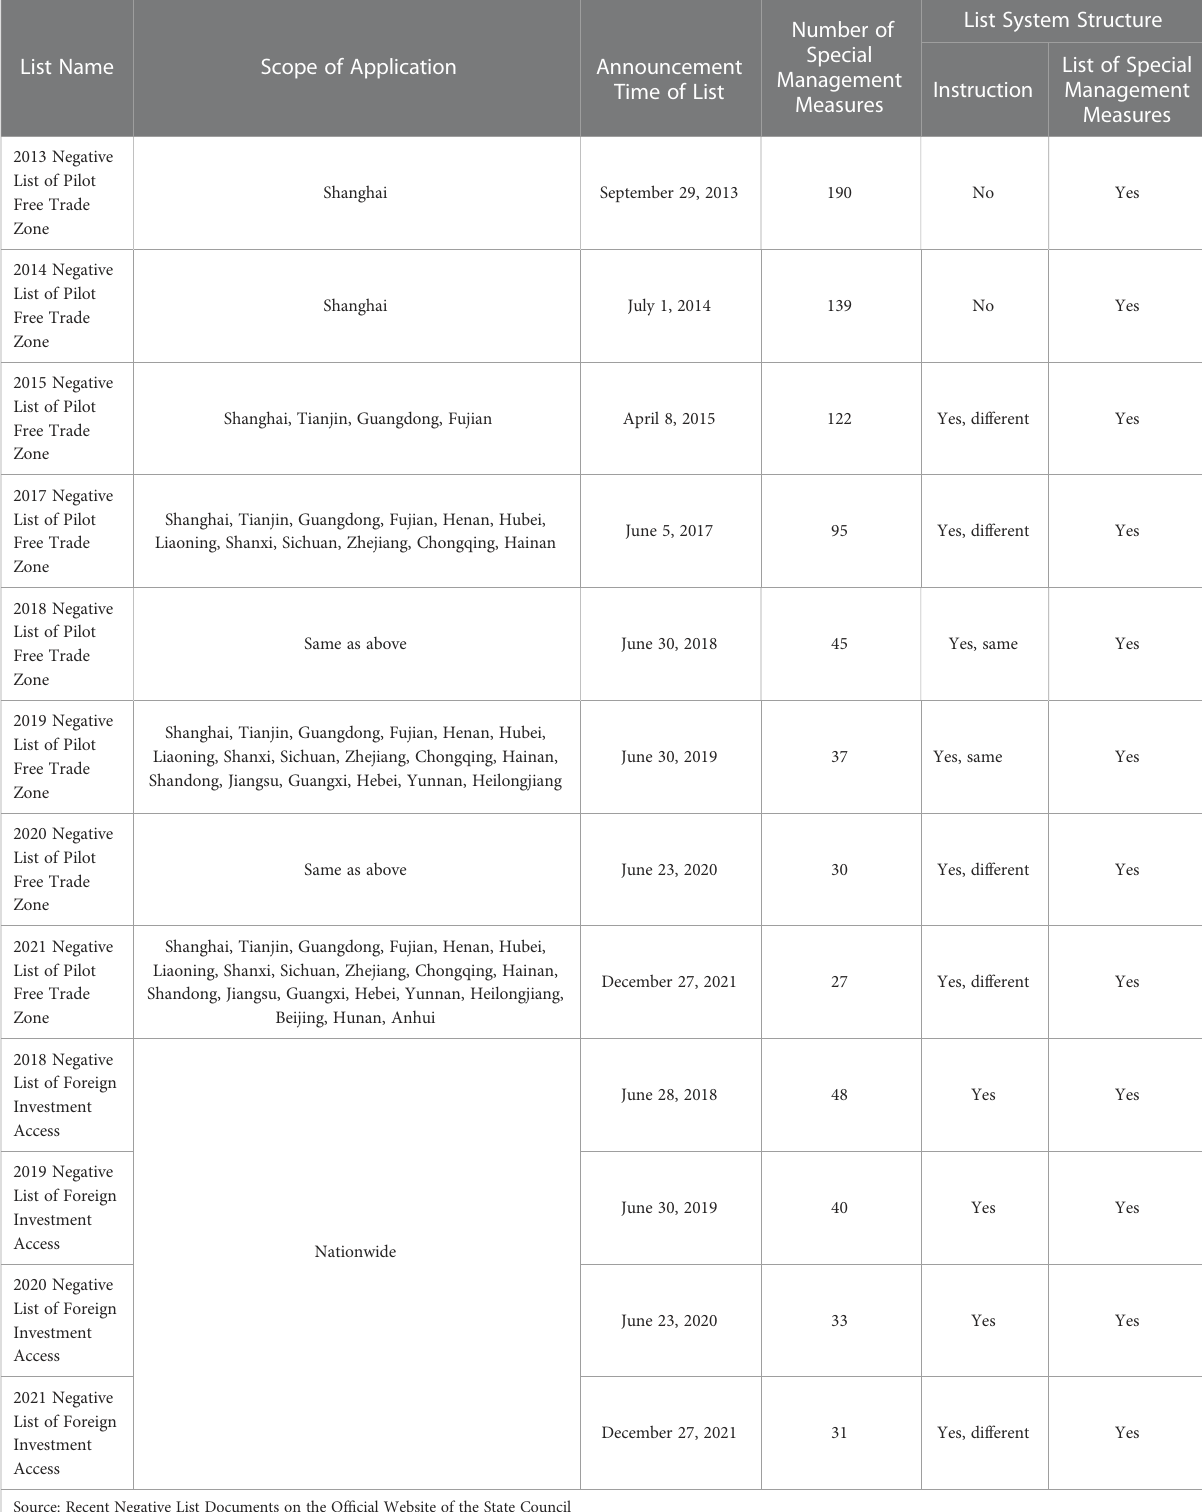
TABLE 1 Changes in the Scope of the Application of the Pilot Free Trade Zones and the National Versions of the Negative List of Foreign Investment Access (2013-2021).